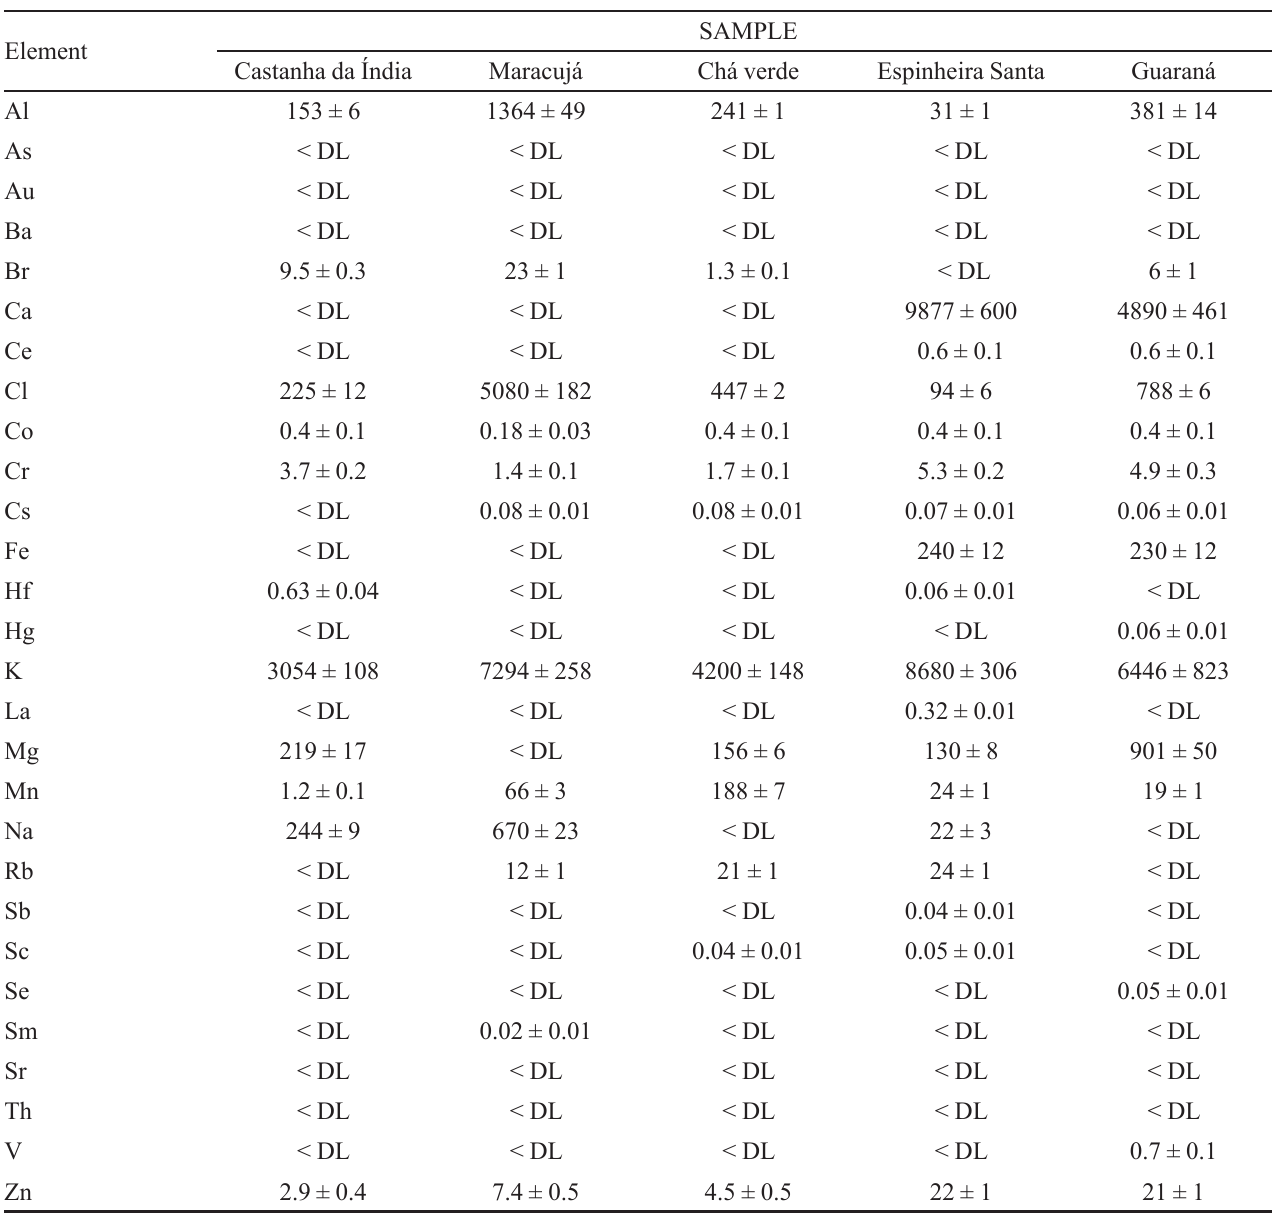
TABLE III - Elemental concentration (mg kg -1 ) of the samples: Castanha da Índia, Maracujá and Chá Verde (DE); Espinheira Santa and Guaraná (P)